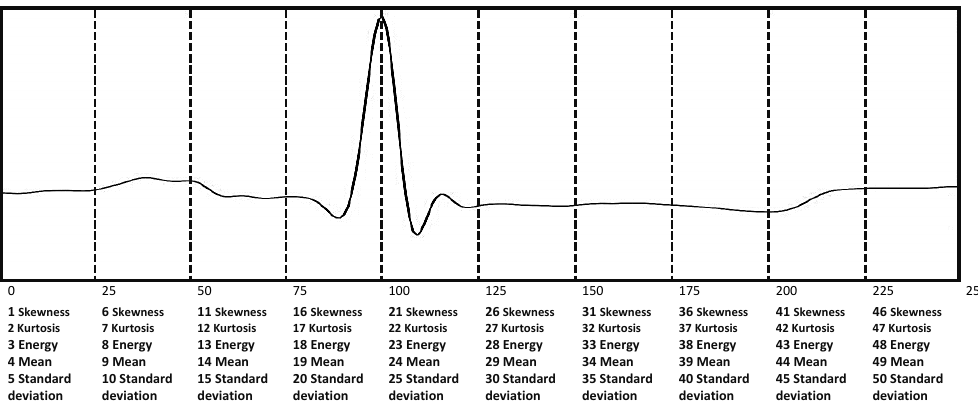
Figure 9. Feature extraction from